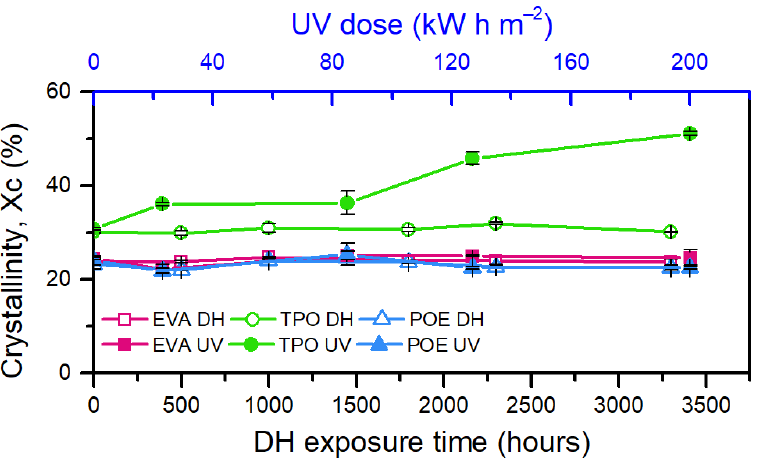
Figure 10. Evolution of crystallinity over UV and DH exposure of the encapsulants (EVA, TPO, and POE).